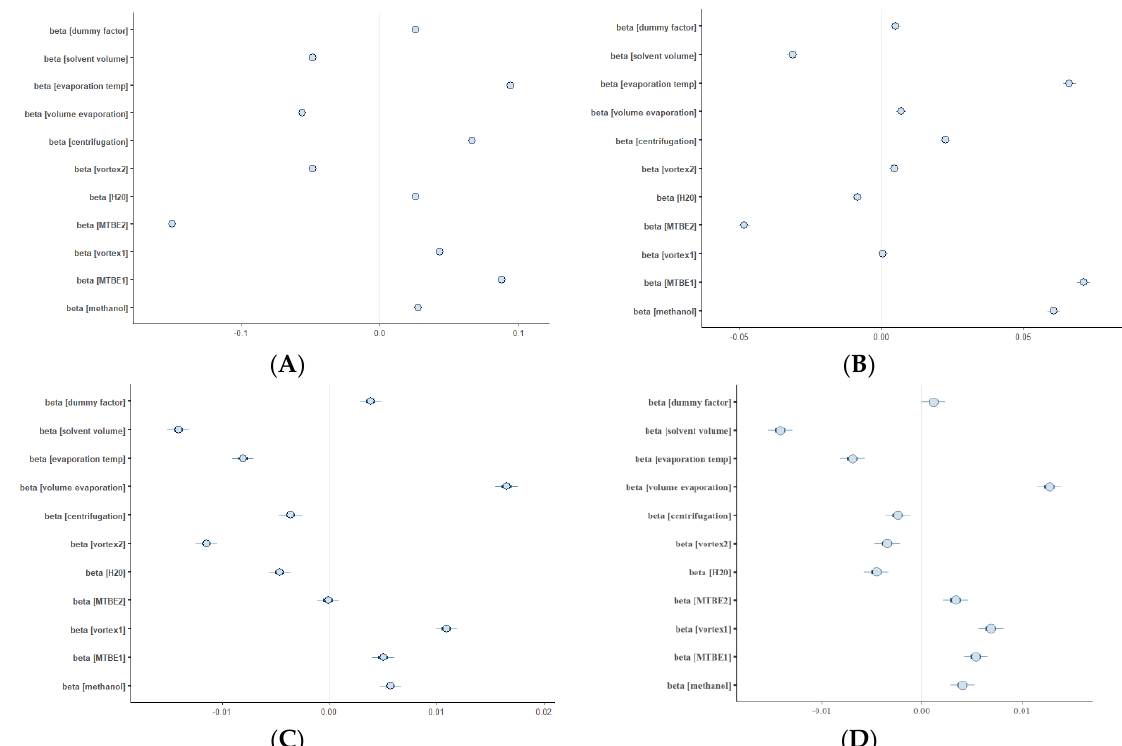
Figure 9. Plots showing the multilevel modelling results. The blue dots represent the coefficient ( beta ) values of 11 factors, together with their standard deviations. The response was the abundance of metabolites detected in ( A ) RP-LC-MS (+), ( B ) RP-LC-MS(-), ( C ) HILIC-LC-MS(+), ( D ) HILIC-LC-MS(-) analyses.